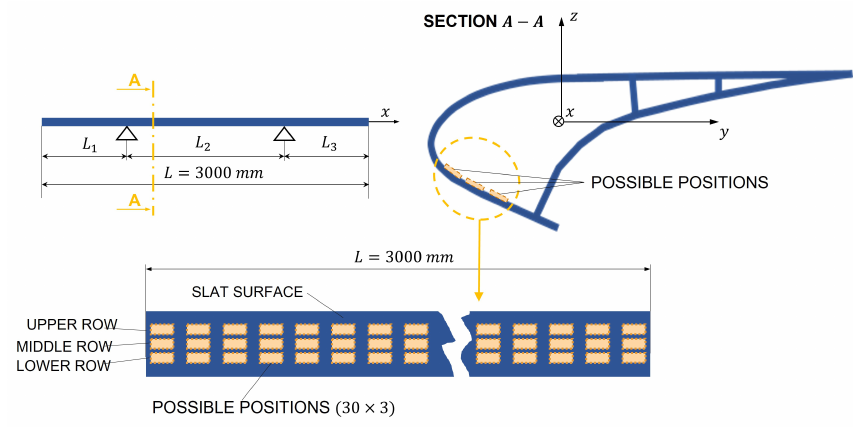
Figure 11 schematizes the grid of test positions.